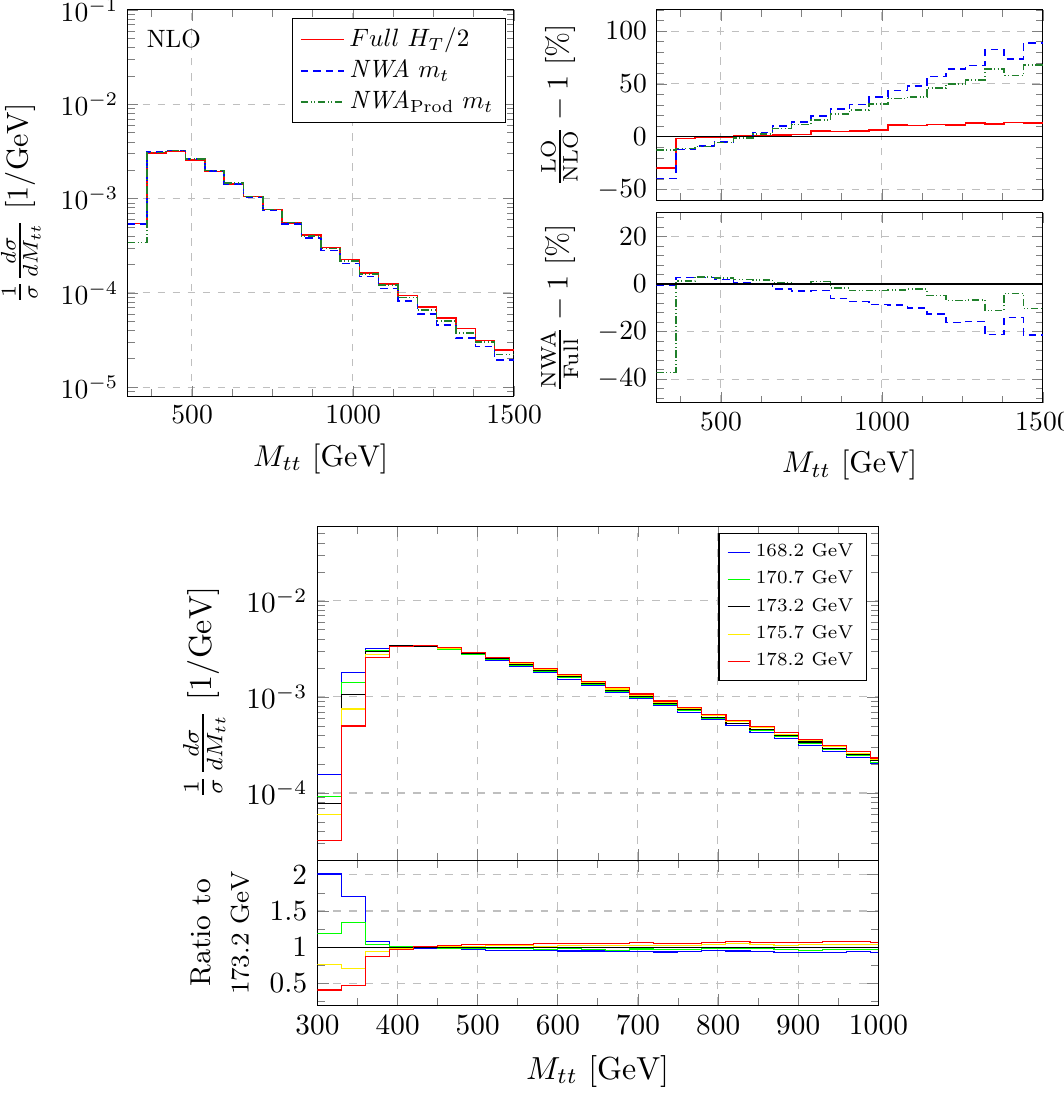
Figure 14 . Normalised M distribution at NLO QCD for the pp t (cid:22) t process at the LHC with p s = 13 TeV. The CT14 PDF set is used. Upper panel: three